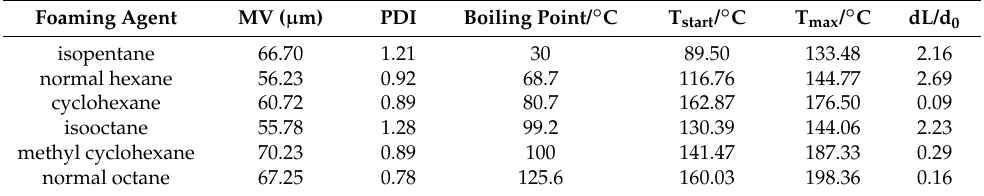
Figure 5. SEM of the microspheres with octane and isooctane as foaming agents: ( a , b ) unexpanded; ( c , d ) expanded. Table 1. Expandable properties of the microspheres with the different foaming agents.